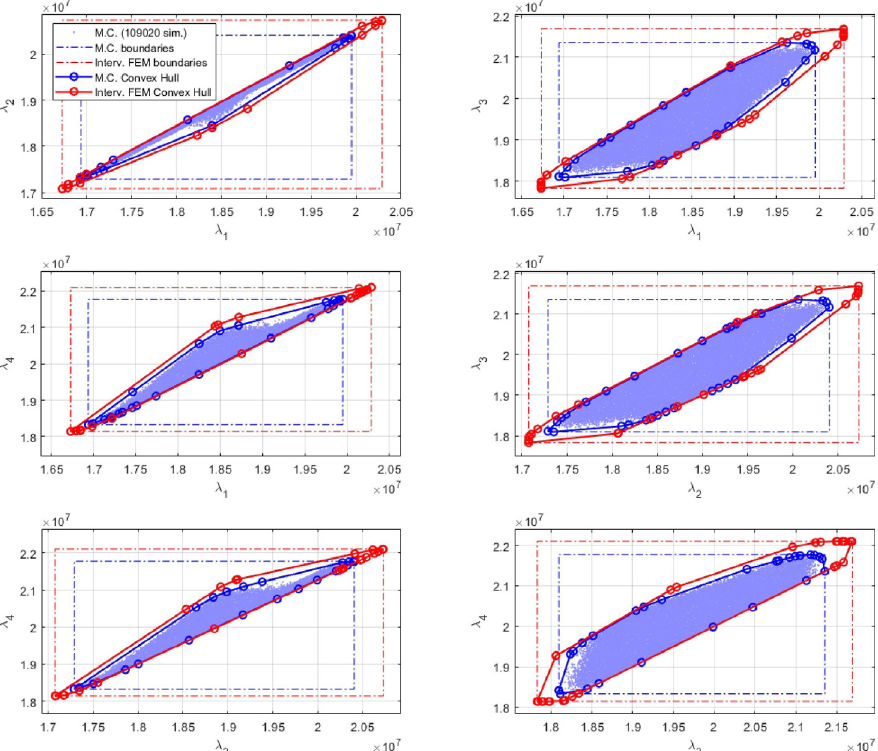
Figure 4. Output uncertain intervals and convex hulls for the Interval-based procedure and MC Simulation for buckling loads (dimensionless buckling load